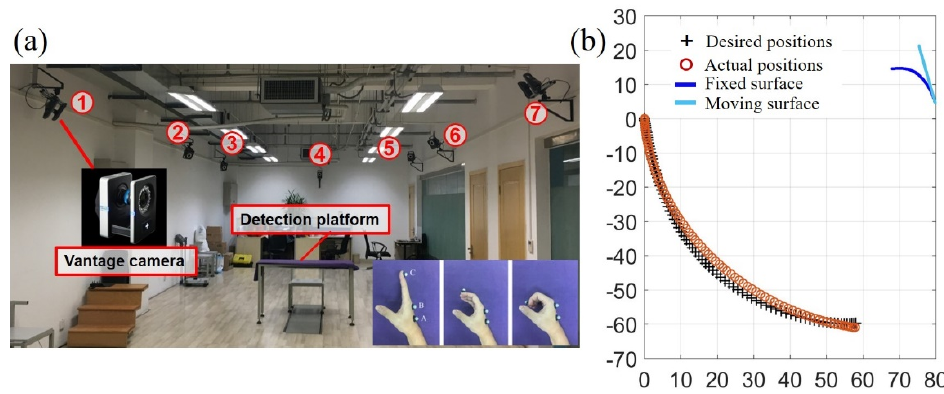
Figure 5. Design of an Involute Joint for the End-effect Finger. ( a ) Motion capture of the fingertip. ( b ) Optimization results for the involute joint. ( b ) Optimization results for the involute joint.